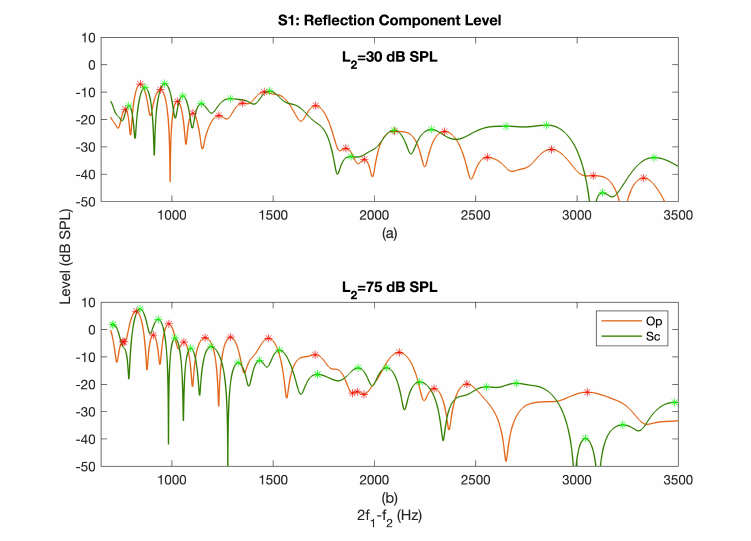
Figure 8. L refl as a function of frequency at L 2 = 30 dB SPL (panel ( a )) and L 2 = 75 dB SPL (panel ( b )) in the Op (orange curves) and Sc (green curves) paradigms for subject S1. The red and green stars indicate the maxima in the Op and Sc curves,